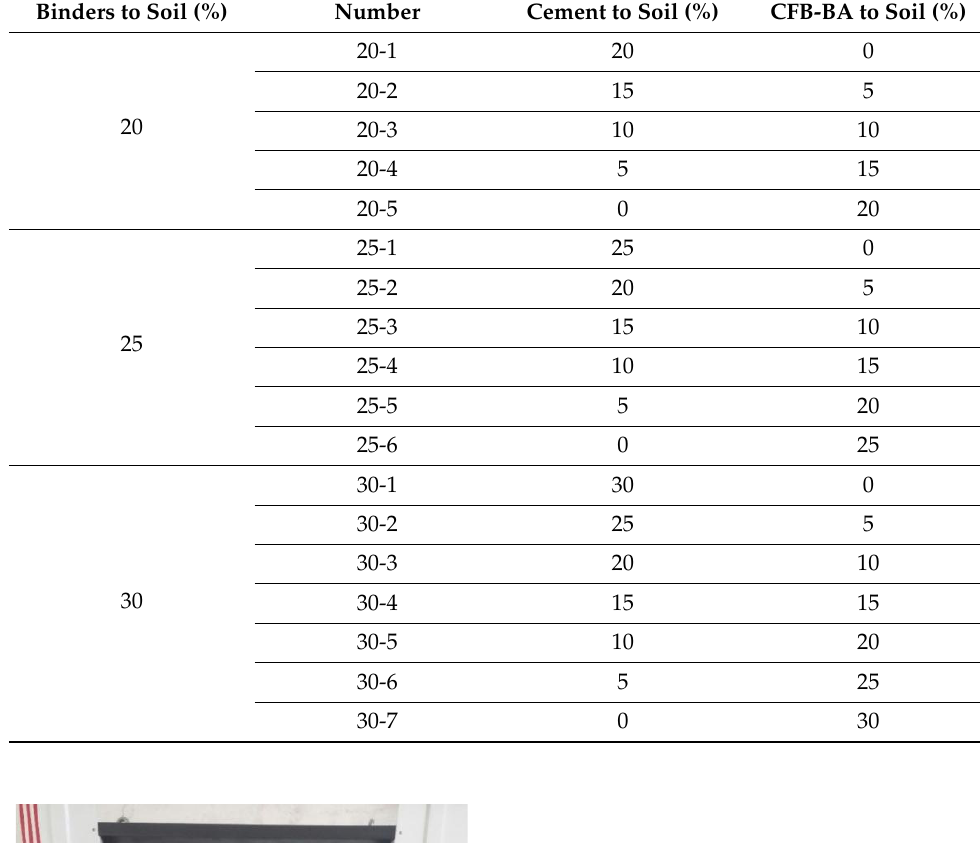
Table 4. Tested mixture ratios of CFB-BA-cement-stabilised soil.